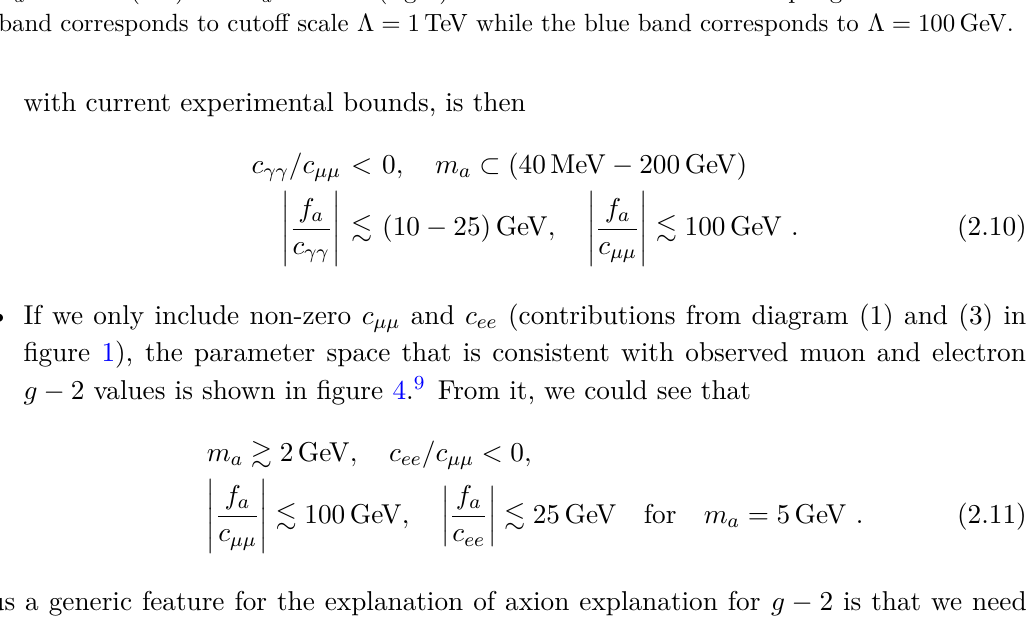
Figure 2 . Allowed regions (red) in the ( c µµ /f a , c γγ /f a ) plane to explain muon g − 2 at 2 σ level, for m = 1 GeV (left) and m = 5 GeV (right). We set all the other axion couplings to be zero. The a a red band corresponds to cutoff scale Λ = 1 TeV while the blue band corresponds to Λ = 100